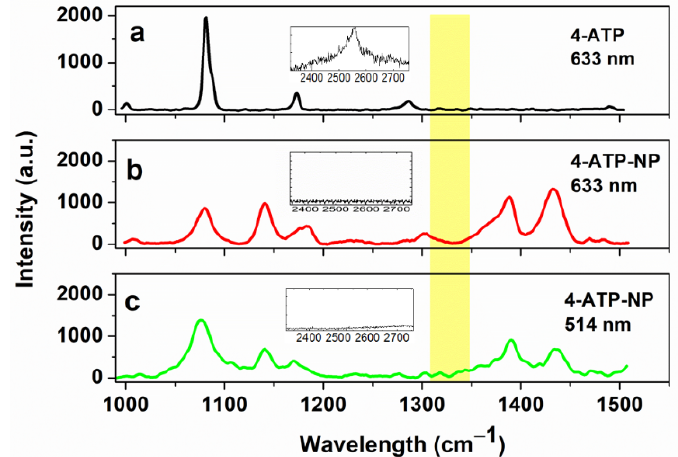
Figure 3. ( a ) Raman spectrum of 4-ATP in water solution obtained with 633 nm laser wavelength. ( b , c ) Raman spectra of 4-ATP conjugated to 50 nm gold NPs, obtained with a 633 nm and 514 nm laser wavelength, respectively. The spectral range corresponding to the S–H stretching mode is shown in the insets. The yellow band highlights the region where the Raman marker should appear (not present here).